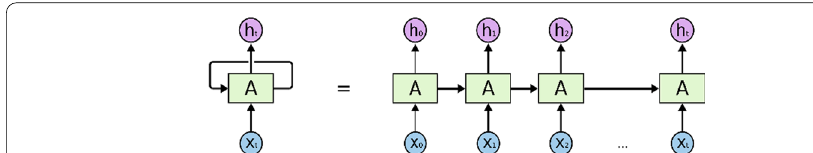
Fig. 1 An unrolled recurrent neural network